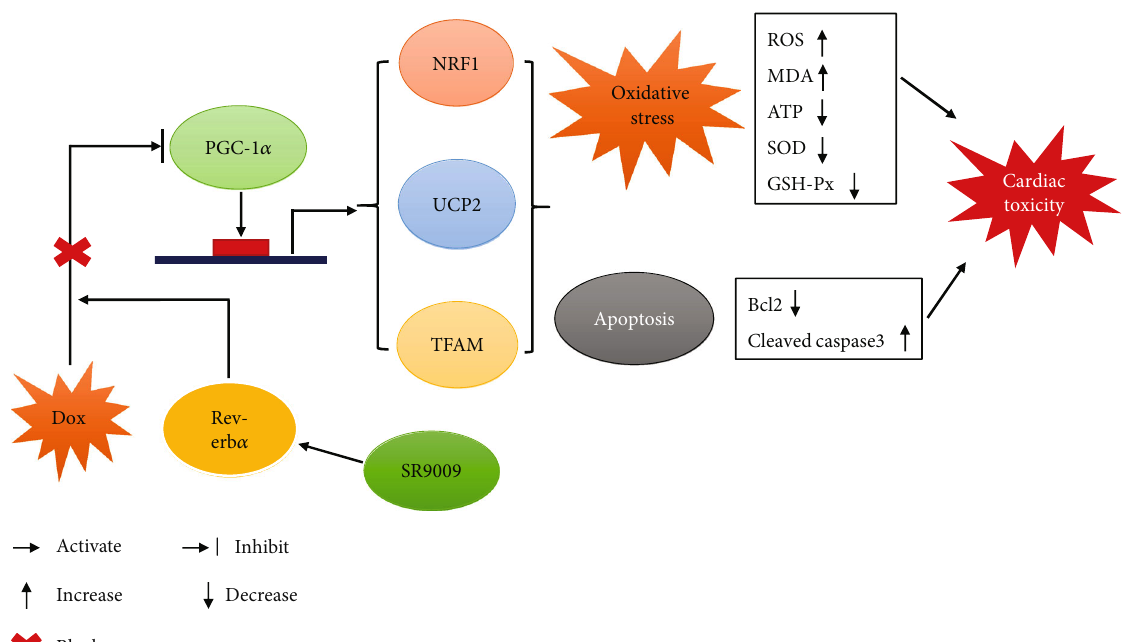
Figure 6: A schematic representation of SR9009-activated Rev-erb α which protects against doxorubicin-induced cardiotoxicity through PGC-1 α signaling. Activation of Rev-erb α by SR9009 preserves PGC-1 α and downstream signaling NRF1, UCP2, and TFAM, which further alleviates oxidative stress and apoptosis, consequently contributing to inhibition of DOX-induced